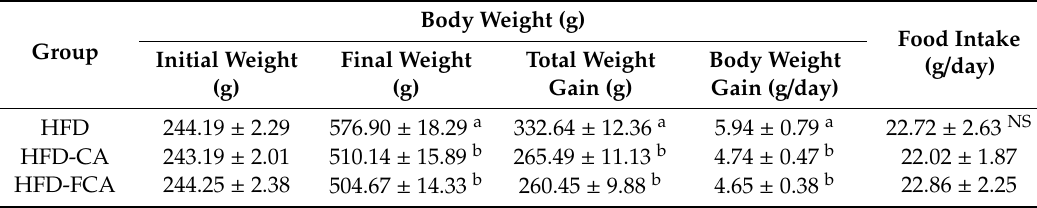
Table 2. Changes in body weight gain and food intake of rats fed with experimental diets.